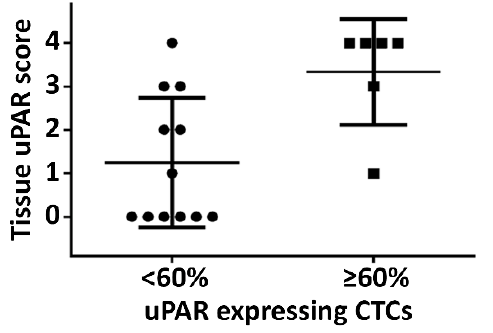
Figure 3. Tissue expression of uPAR is increased in patients where more than 60% of their epithelial cell adhesion molecule (EpCAM) selected circulating tumour cells (CTCs) co-expressed uPAR. Mean score in the lower group 1.3, higher group 3.3 (n = 18, p = 0.0008).